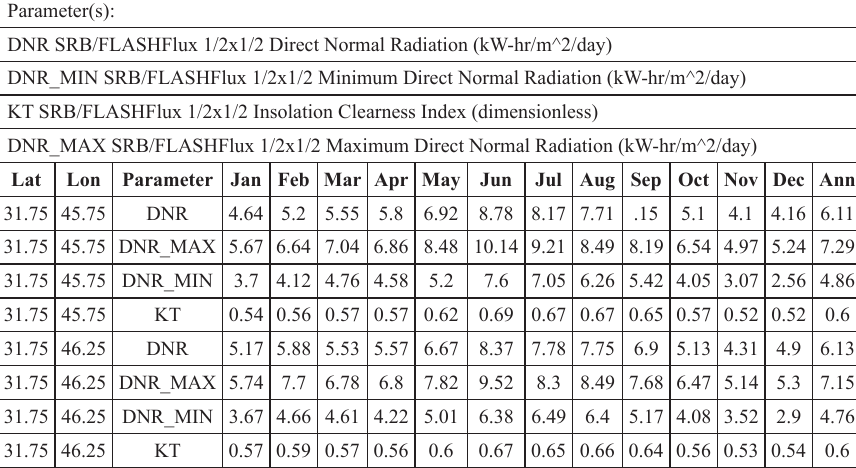
Table 2. Parameters average radiation in